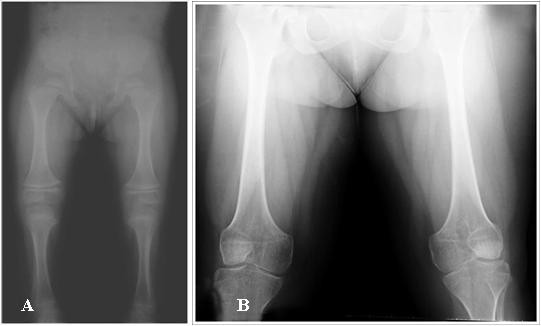
Radiographs of patient 1. A. 4 years. B. 28 years. Note short iliac bones, flattened femoral heads, short and broad femoral neck. Short femoral and tibial diaphysys, methaphyseal widening and broad femoral ends.